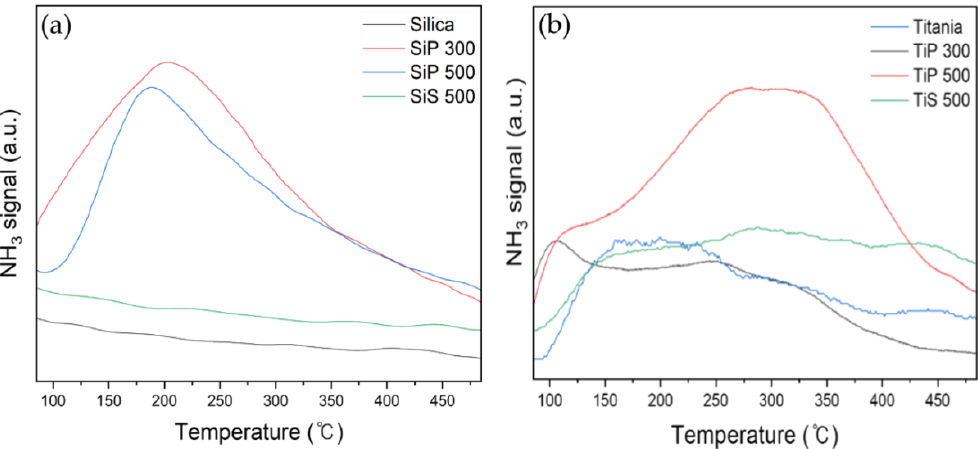
Figure 4. NH 3 -TPD data of ( a ) silica-based catalysts and ( b ) titania-based catalysts.